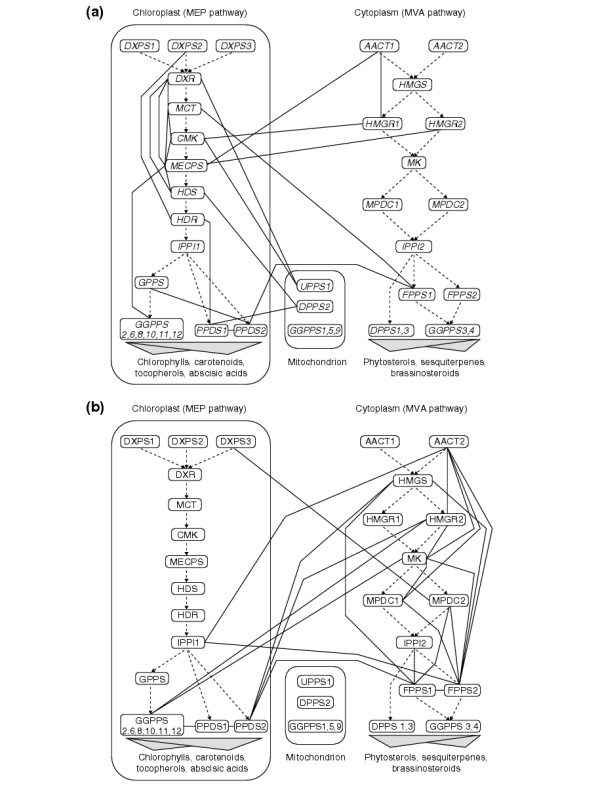
Dependencies between genes of the isoprenoid pathways according to the frequentist modified GGM method. (a) Subgraph of the gene module in the MEP pathway; (b) subgraph of the gene module in the MVA pathway. For an explanation of what the edges and shading indicate see legend to Figure 2.